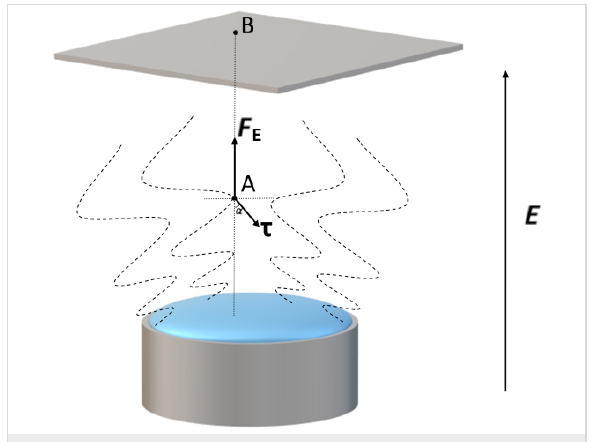
Figure 6: The forces acting at point A of the jet in the FSE process. According to the above equations and figures, the distribution of the electric field intensity plays a very important role in the FSE process since multiple jets form on the entire spinning area. To optimize the electric field distribution while keeping the applied voltage constant, the solution reservoir of the FSE apparatus was modified yielding the MBE, MFSE, OSFSE and SSFSE devices. It is necessary to simulate the distribution of the electric field intensity in the different FSE processes to illustrate and compare their spinning